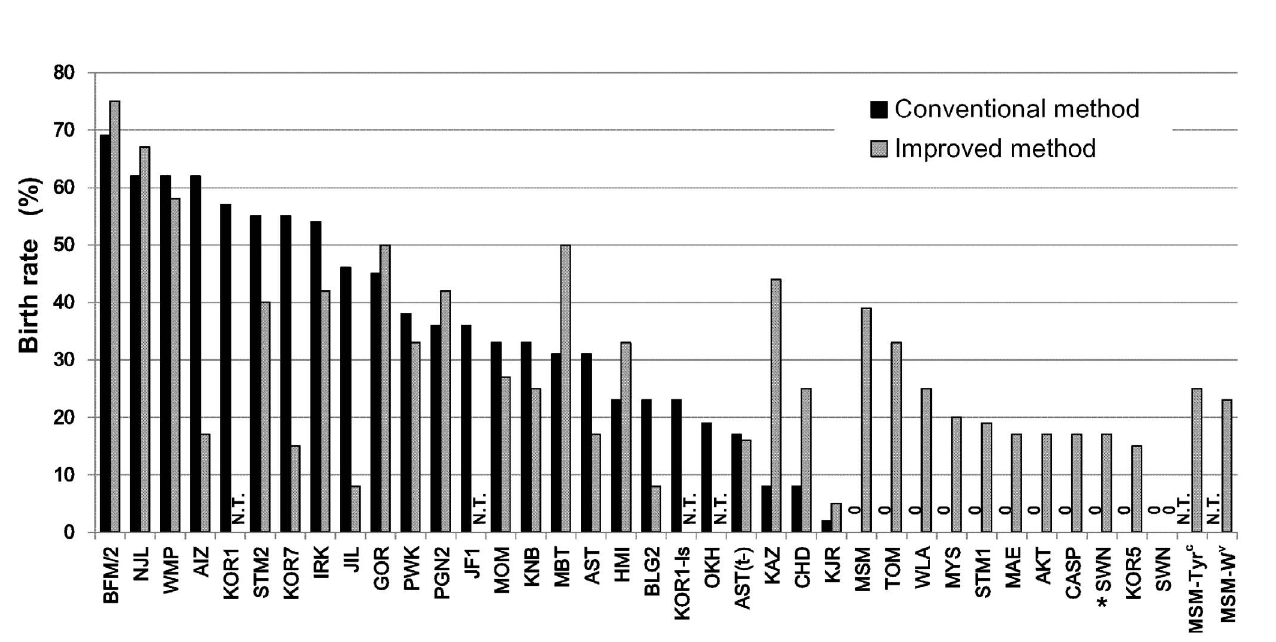
Figure 5. Full-term development of cryopreserved embryos after conventional or improved embryo transfer methods. Living offspring were obtained from all 37 strains with either the conventional (black) or the improved (gray) embryo transfer method. While 10 out of 35 strains failed to produce offspring by the conventional method, all strains tested produced offspring successfully by the improved method (33 strains). Offspring of the SWN strain were born in combination of embryos derived from natural mating and the improved embryo transfer method (asterisk). The detailed data set is available in Table S6. N.T., not